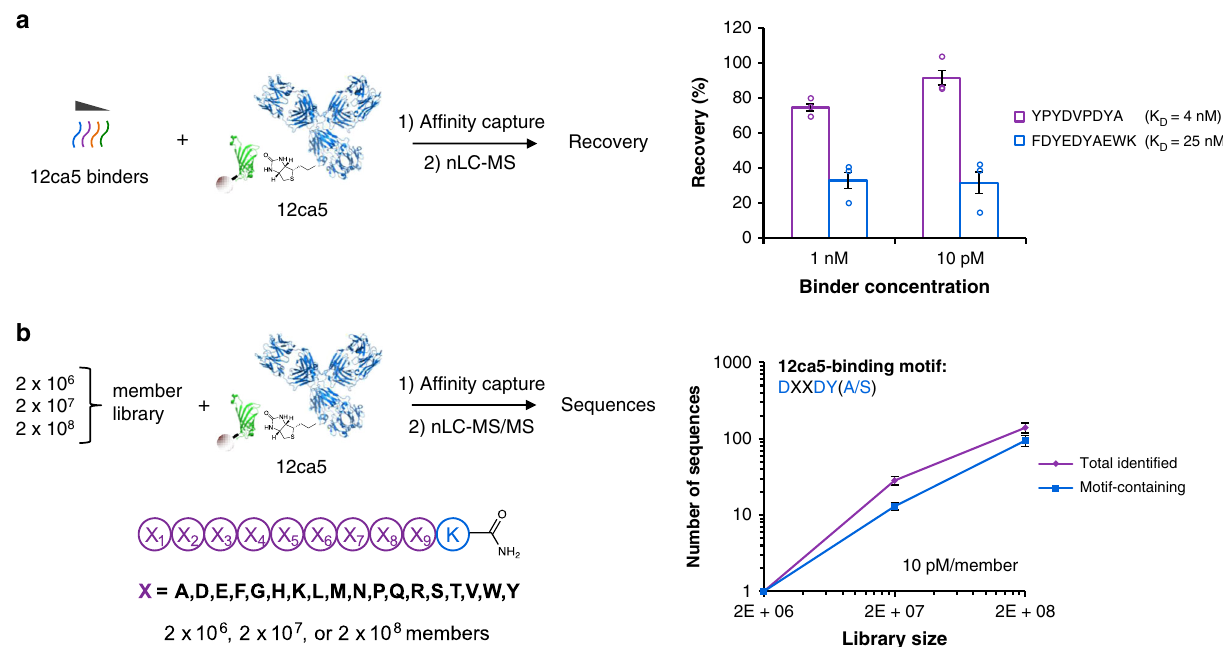
Fig. 2 Magnetic bead capture recovers high-af fi nity binders from both simple mixtures and random libraries. a High-af fi nity 12ca5-binding peptides were recovered effectively from a concentration of 10 pM, which corresponds to the concentration of an individual library member in a 10 8 -member library at 1 mM total peptide. Recoveries were determined by MS detector response, normalizing to an internal standard. b The number of identi fi ed sequences bearing the 12ca5-binding motif — DXXDY(A/S) — increased in proportion to library diversity, from two million to two hundred million-member libraries. On average, motif-containing sequences represented 71% of all sequences identi fi ed. Error bars correspond to one standard deviation among three technical